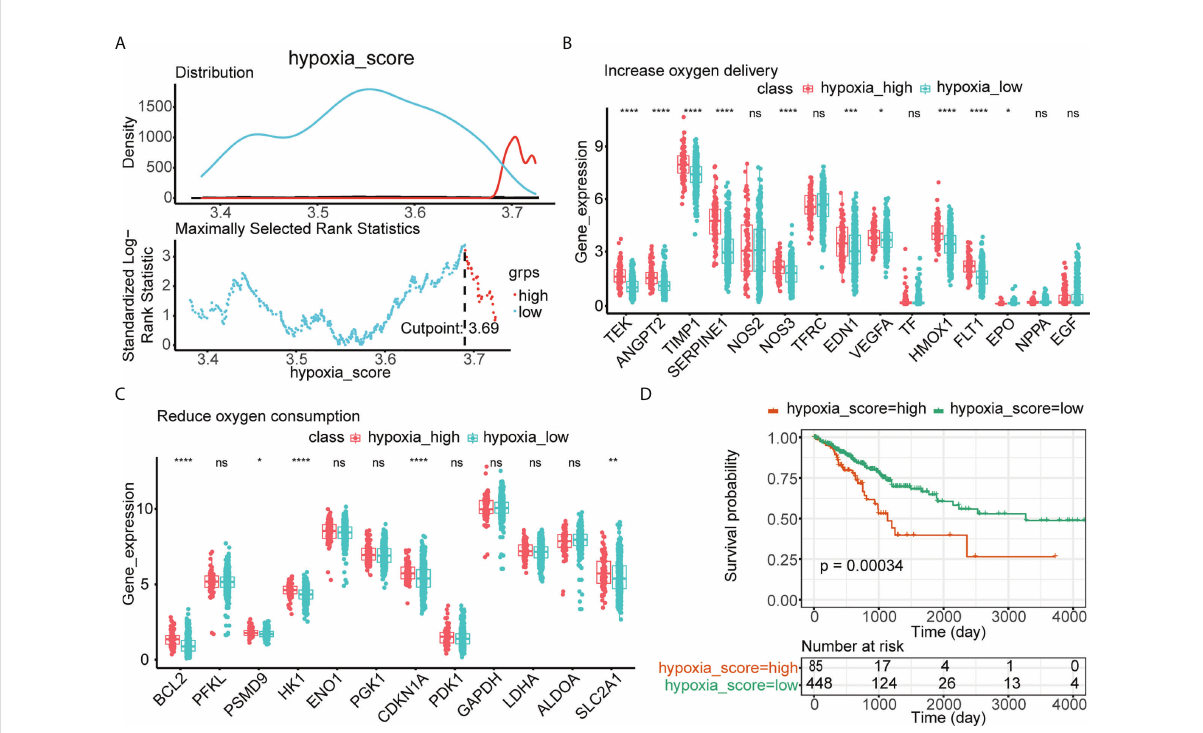
FIGURE 2 Identi fi cation of low- and high-hypoxia groups in TCGA. (A) The optimal threshold of the hypoxia enrichment score calculated by ssGSEA. (B) The expressions of 15 increased oxygen delivery genes in hypoxia-high and hypoxia-low groups in TCGA. (C) The expressions of 12 reduced oxygen consumption genes in hypoxia-high and hypoxia-low groups in TCGA. (D) Kaplan – Meier analysis of TCGA-CRC patients ’ survival in low- and high-hypoxia groups. ns, no signi fi cance; *p< 0.05; **p< 0.01; ***p< 0.001; ****p<